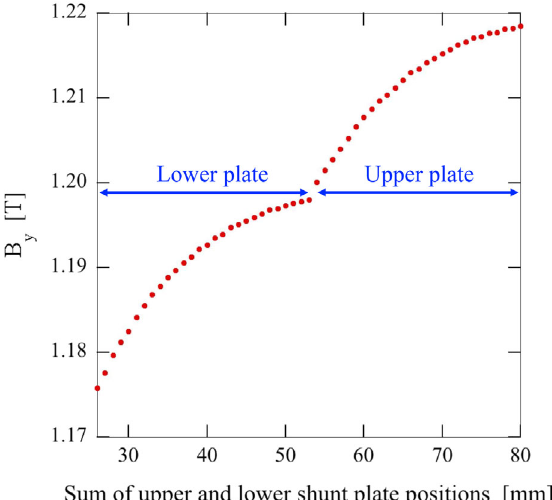
FIG. 12. Temperature dependence of gap field after MS-2 thickness optimization. The value of T data in the range of 26 – 28 °C.